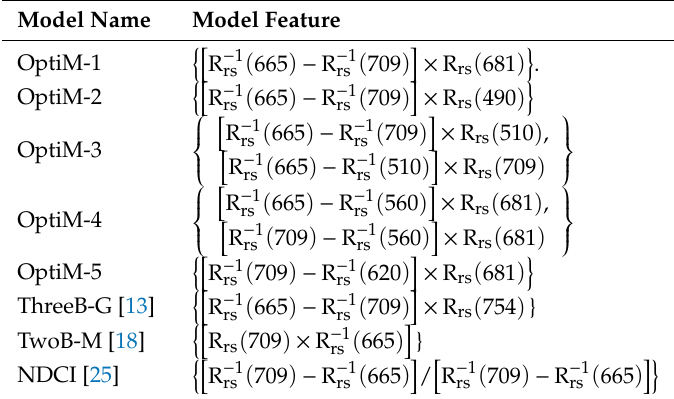
Table 2. Proposed and related Chl-a estimation models.